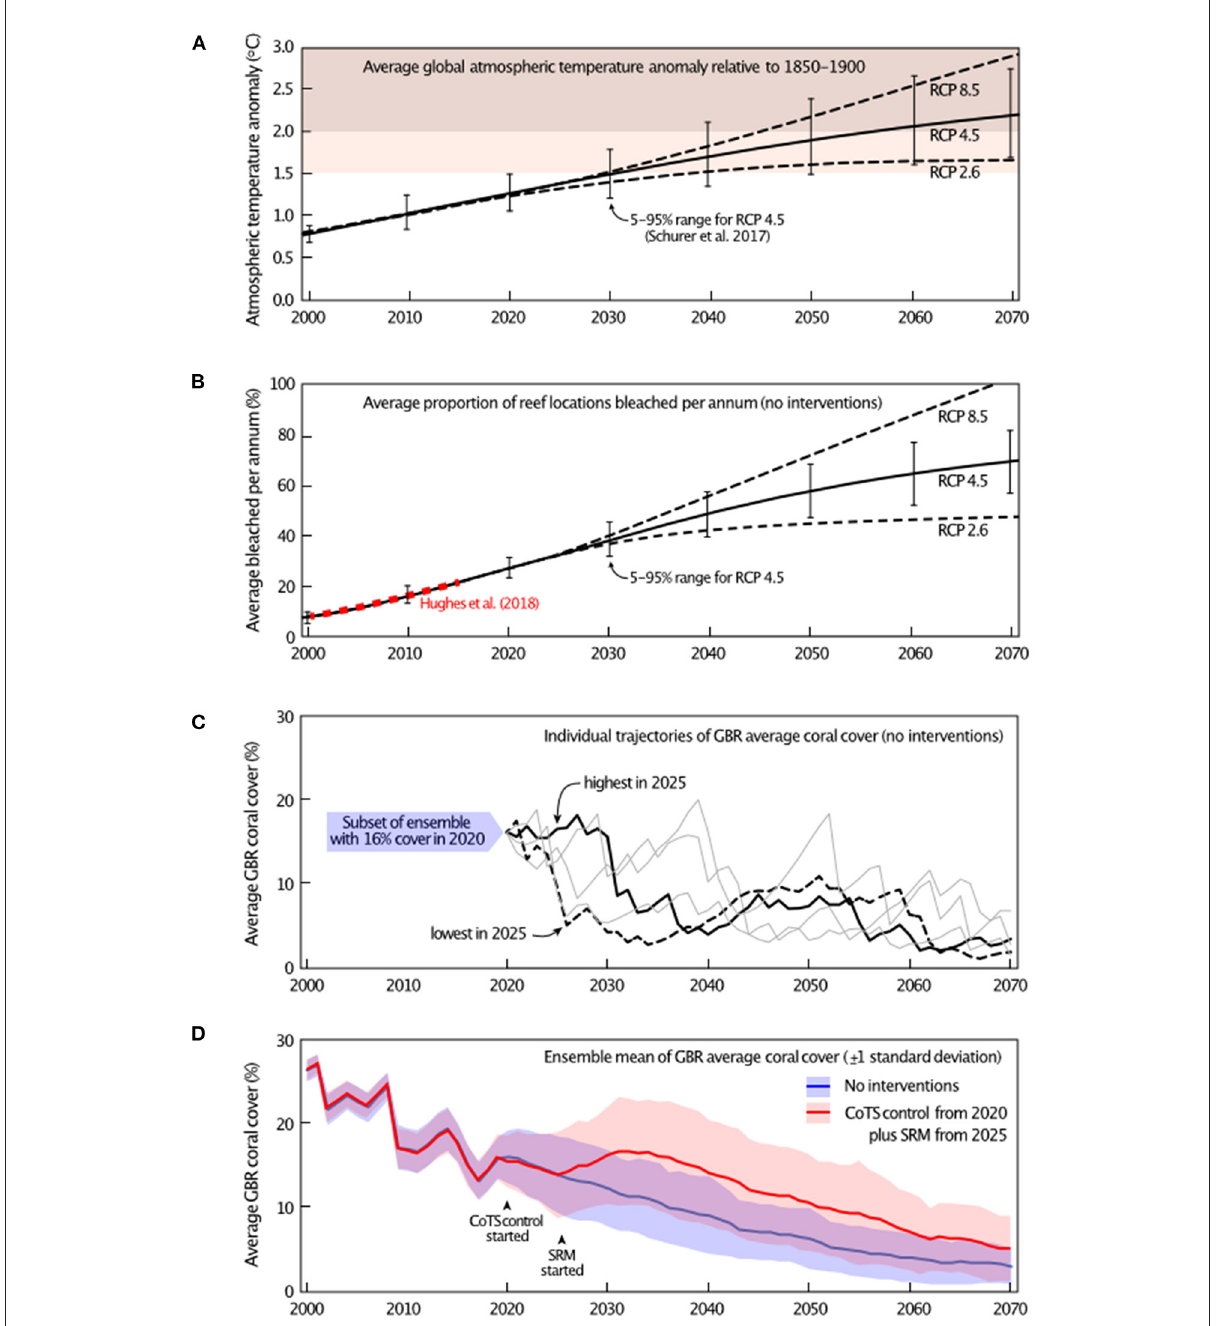
FIGURE2 Modeled projections of climate conditions and GBR responses. (A) Multi-model-mean global atmospheric temperature anomaly relative to 1850–1900 under three RCP scenarios (Schurer et al., 2017). (B) Average proportion of locations bleached per annum under three RCP scenarios, assuming that the past linear relation between trends in mean atmospheric temperature and DHWs continues (Lough et al., 2018), and corresponding estimates from empirical data for 1980–2016 (Hughes et al., 2018). The long-term values are also consistent with the frequency of mass bleaching ( > 8 DHW) estimated from climate model projections for RCP 2.6 (0.35–0.45) and RCP 4.5 (0.55–0.75) (Frieler et al., 2013; Kwiatkowski et al., 2015), as well as forecasts of annual bleaching across nearly all of the GBR by 2070 under RCP 8.5 (van Hooidonk et al., 2016). (C) A sample of five individual trajectories selected from a 100-member model ensemble under RCP 4.5 with no interventions. Trajectories were selected on the basis that they all had close to 16% average coral cover in 2020 equal to the ensemble average in that year and consistent with GBR observations (https://www.aims.gov.au/reef-monitoring/gbr-condition-summary-2019-2020). The solid black line shows the trajectory with the highest average coral cover in 2025, the dashed black line shows the trajectory with the lowest average coral cover in 2025, and the three gray lines show trajectories that had intermediate levels of coral cover in 2025. (D) Ensemble mean ( ± 1 standard deviation) under RCP 4.5 without interventions (blue, scenario 2) and with deployment in the central GBR of five CoTS control vessels from 2020 and SRM of 8 DHW from 2025 (red, scenario 10). Note the strong overlap of the two trajectory ranges